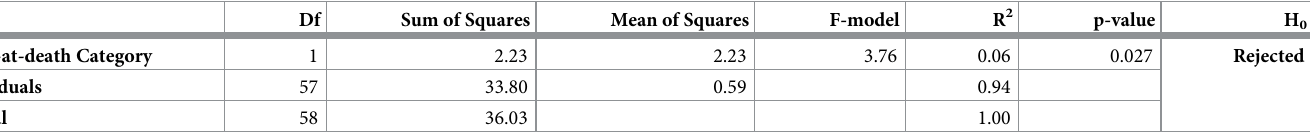
Table 9. Results of Type I PERMANOVA assessing the relationship between age-at-death category (either younger or older) and wear facet area composition in the industrial material.